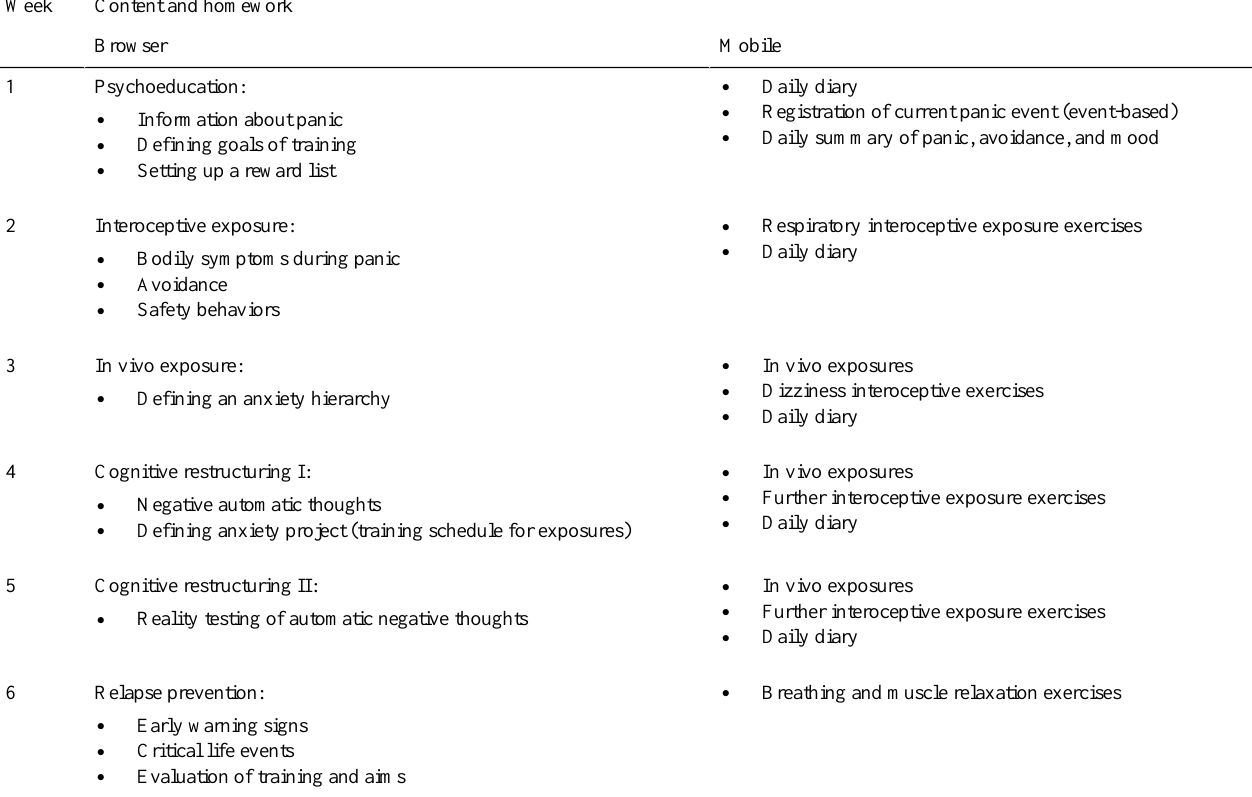
Table 1. Overview of